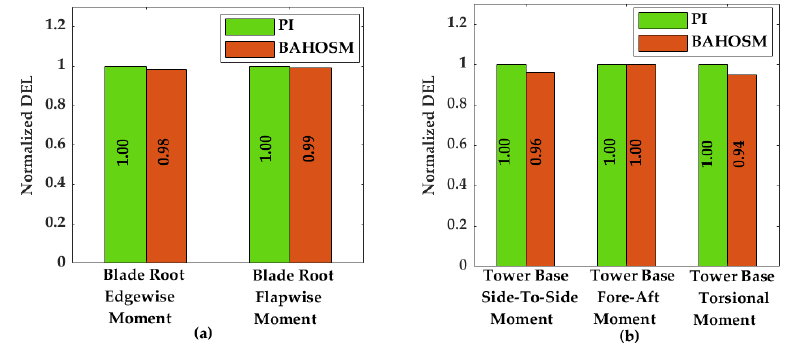
Figure 10. Normalized DEL of the blade root ( a ) and the tower base ( b ) in Case 2.